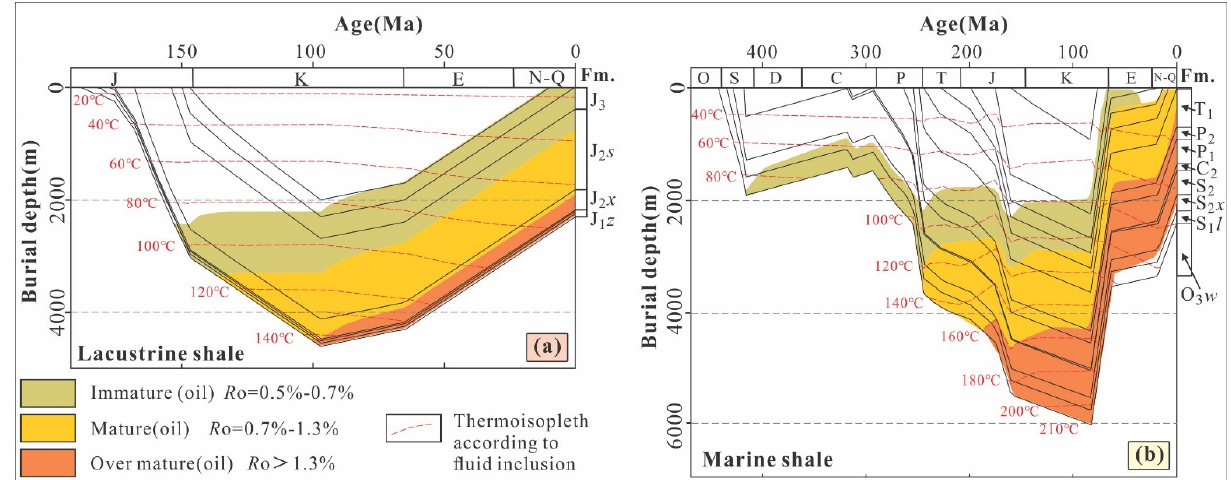
Figure 11. The tectonic evolution characteristics of the marine and lacustrine shale. ( a ) The burial and thermal history of the lacustrine shale in Ziliujing Formation in Fuling area, modified from [10]. ( b ) The burial and thermal history of the marine shale in Wufeng–Longmaxi Formation in well JY1 (Figure 1), modified from [47].